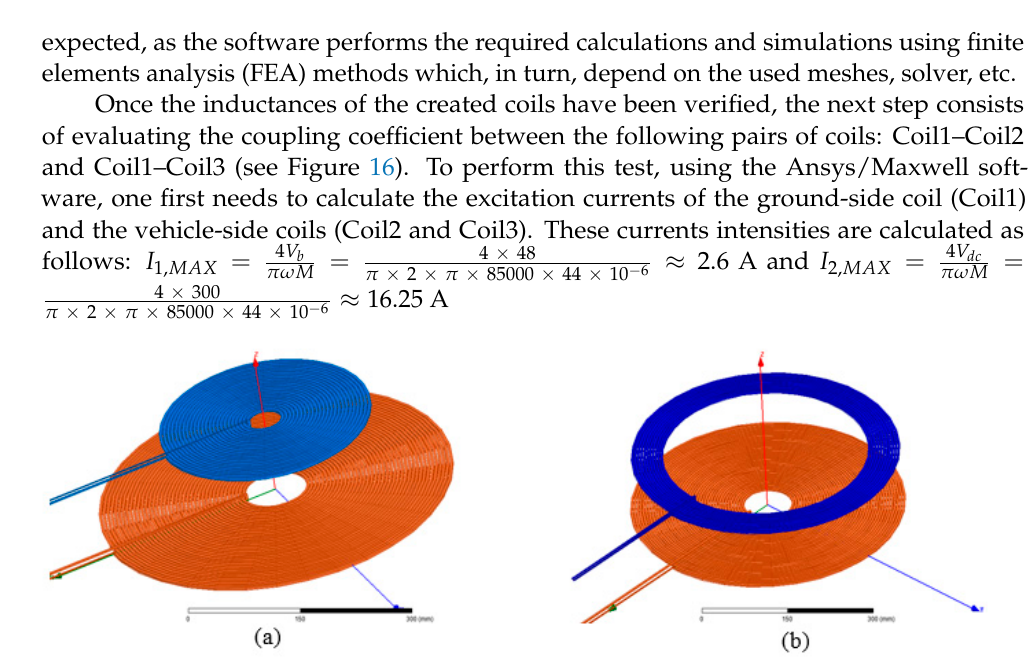
Figure 16. Image of the tested pairs of the coils: ( a ): Coil1–Coil2 and ( b ): Coil1–Coil3.